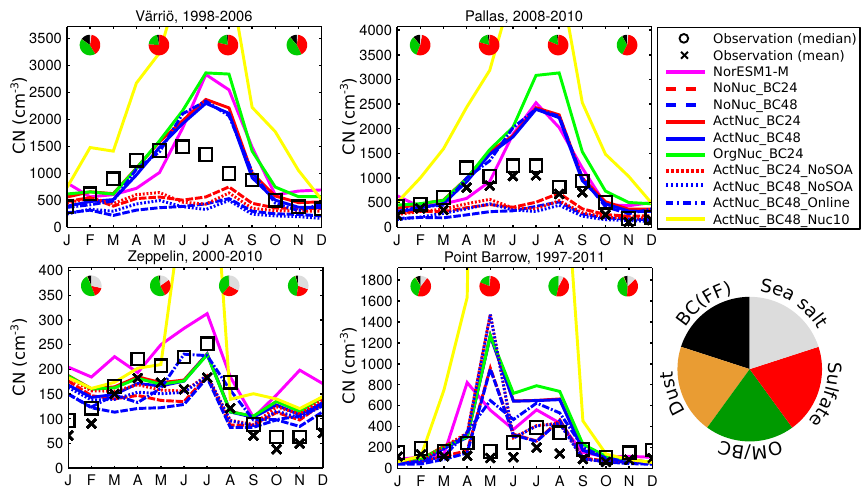
Figure 5. Comparison against Arctic site observations. The year range used for observation averaging is indicated at the top of each panel. The vertical axis is not scaled to include simulation ActNuc_BC48_Nuc10. The pie charts indicate the relative contribution of aerosol components to number concentration in NorESM simulations (ActNuc_BC48) in February, May, August and November. Included aerosol components are sea salt, sulfate, mixed OM/BC mode, dust and fossil fuel BC. For a detailed description of the NorESM aerosol model, see Kirkevåg et al. (2013).